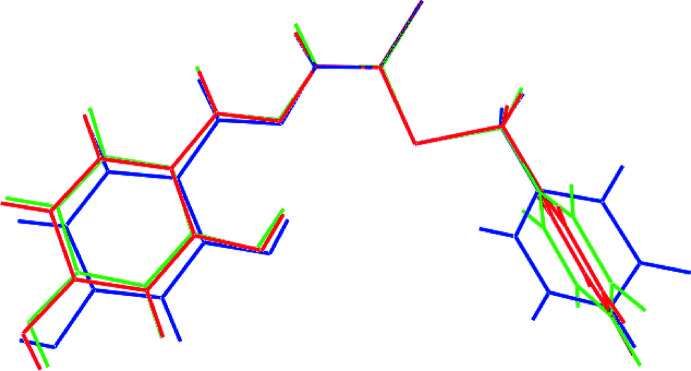
An overlay diagram of the two independent hydrazine carbodi­thio­ate mol­ecules in (I): S1-mol­ecule (red image) and S3-mol­ecule (blue), and geometry optimized structure (green). The mol­ecules have been overlapped so the CS2 residues are coincident.